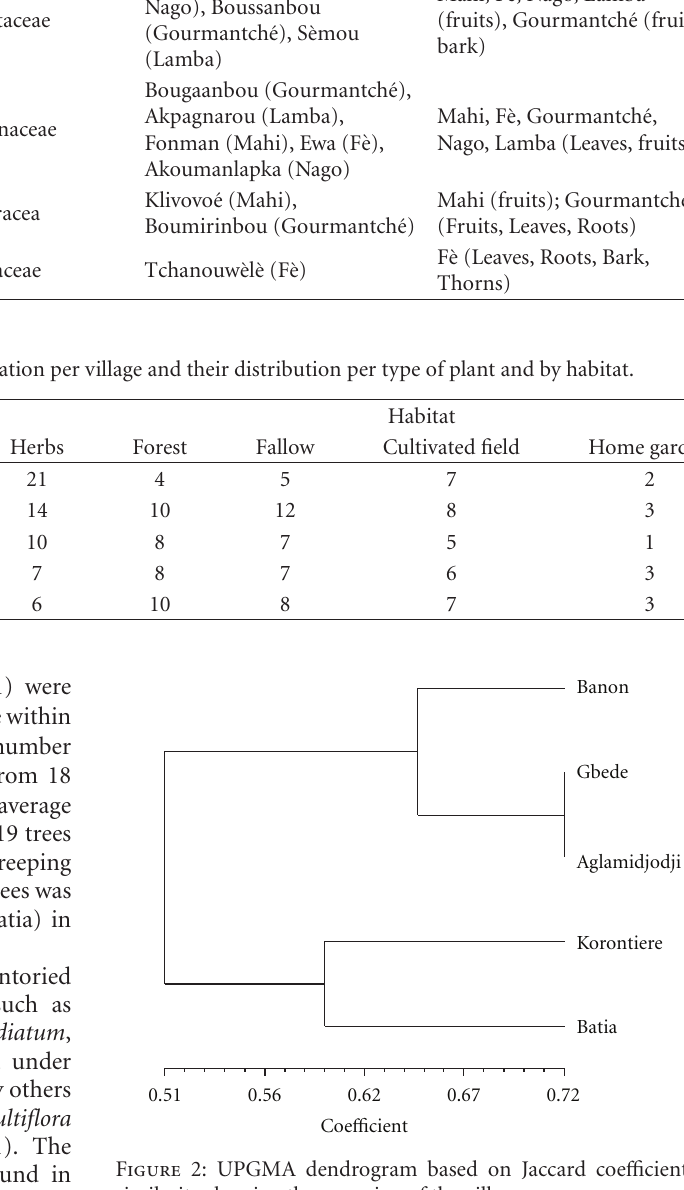
Figure 2: UPGMA dendrogram based on Jaccard coe ffi cient of similarity showing the grouping of the